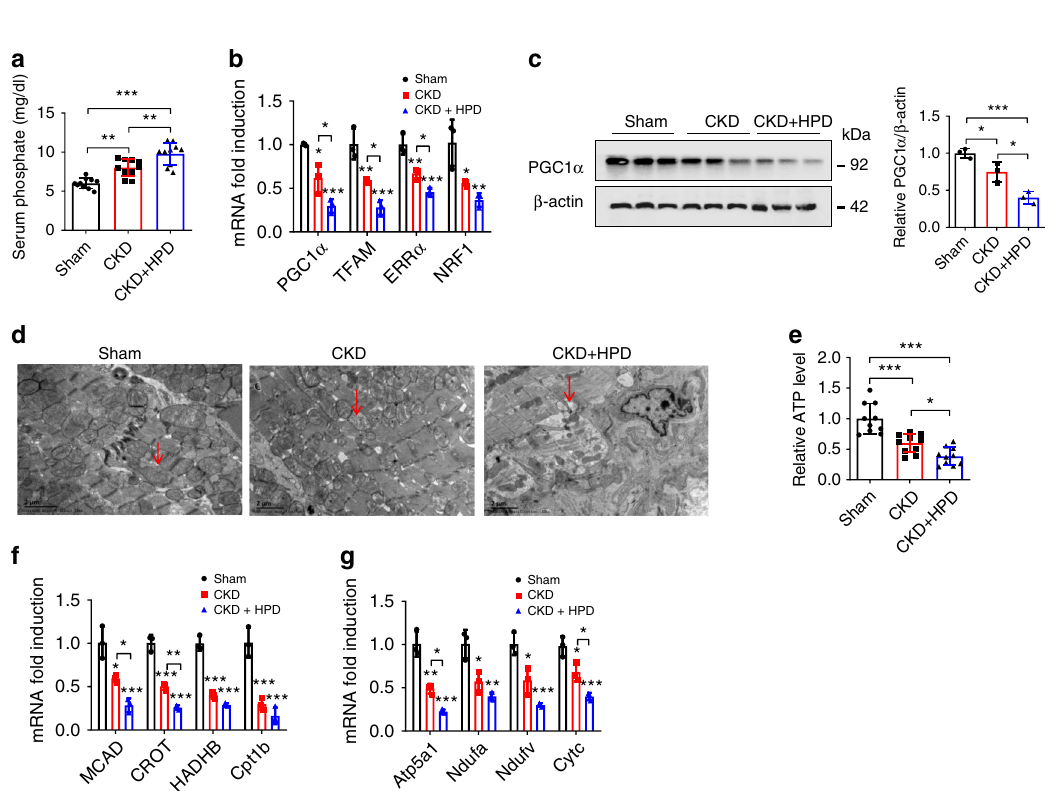
Fig. 2 HP induces PGC1 α reduction and mitochondrial energy metabolism dysfunction in vitro. a H9c2 cells were treated with urea (1.2 mg/ml), serum creatinine (Scr, 80 μ g/ml), uric acid (UA, 80 μ g/ml), parathyroid hormone (PTH, 90 ng/ml), trimethylamine- N -oxide (TMAO, 0.751 μ g/ml), HP (84 μ g/ ml), FGF23 (20 ng/ml), β 2-microglobulin (B2M, 20 μ g/ml), indoxyl sulfate (IS, 125 μ g/ml), p -cresyl sulfate (PCS, 47 μ g/ml), and indole-3-acetic acid (IAA, 3.5 μ g/ml), separately. mRNA was extracted for qPCR analysis of PGC1 α expression. b , c qPCR and western blot analysis of PGC1 α expression in H9c2 cells incubated with the serum of healthy donors or CKD patients for 24 h. d – g qPCR and representative western blot analysis of PGC1 α expression in H9c2 cells treated with control, various doses of HP for 24 h or HP (8.4 mg/dl) for various durations. h – p Oxygen consumption rate (OCR) ( h ), relative ATP level ( i ), relative mRNA expression of FAO genes ( j ), relative mRNA expression of OXPHO genes ( k ), relative mRNA expression of glycolysis genes ( l ), relative mitochondrial DNA copy number ( m ), ROS production ( n ), and monomer and aggregate JC-1 ( o fl ow cytometry; p representative images of laser scanning confocal microscopy. Scale bar, 10 μ m) in H9c2 cells treated with control or HP for 24 h. Data are shown as mean ± SD and were analyzed by a two-tailed unpaired t -test ( a – c , h – o ) or one-way ANOVA ( d – g ). n = 3 ( a – g , i – p ) or n = 4 ( h ) biologically independent experiments. * P < 0.05, ** P < 0.01, *** P < 0.001.